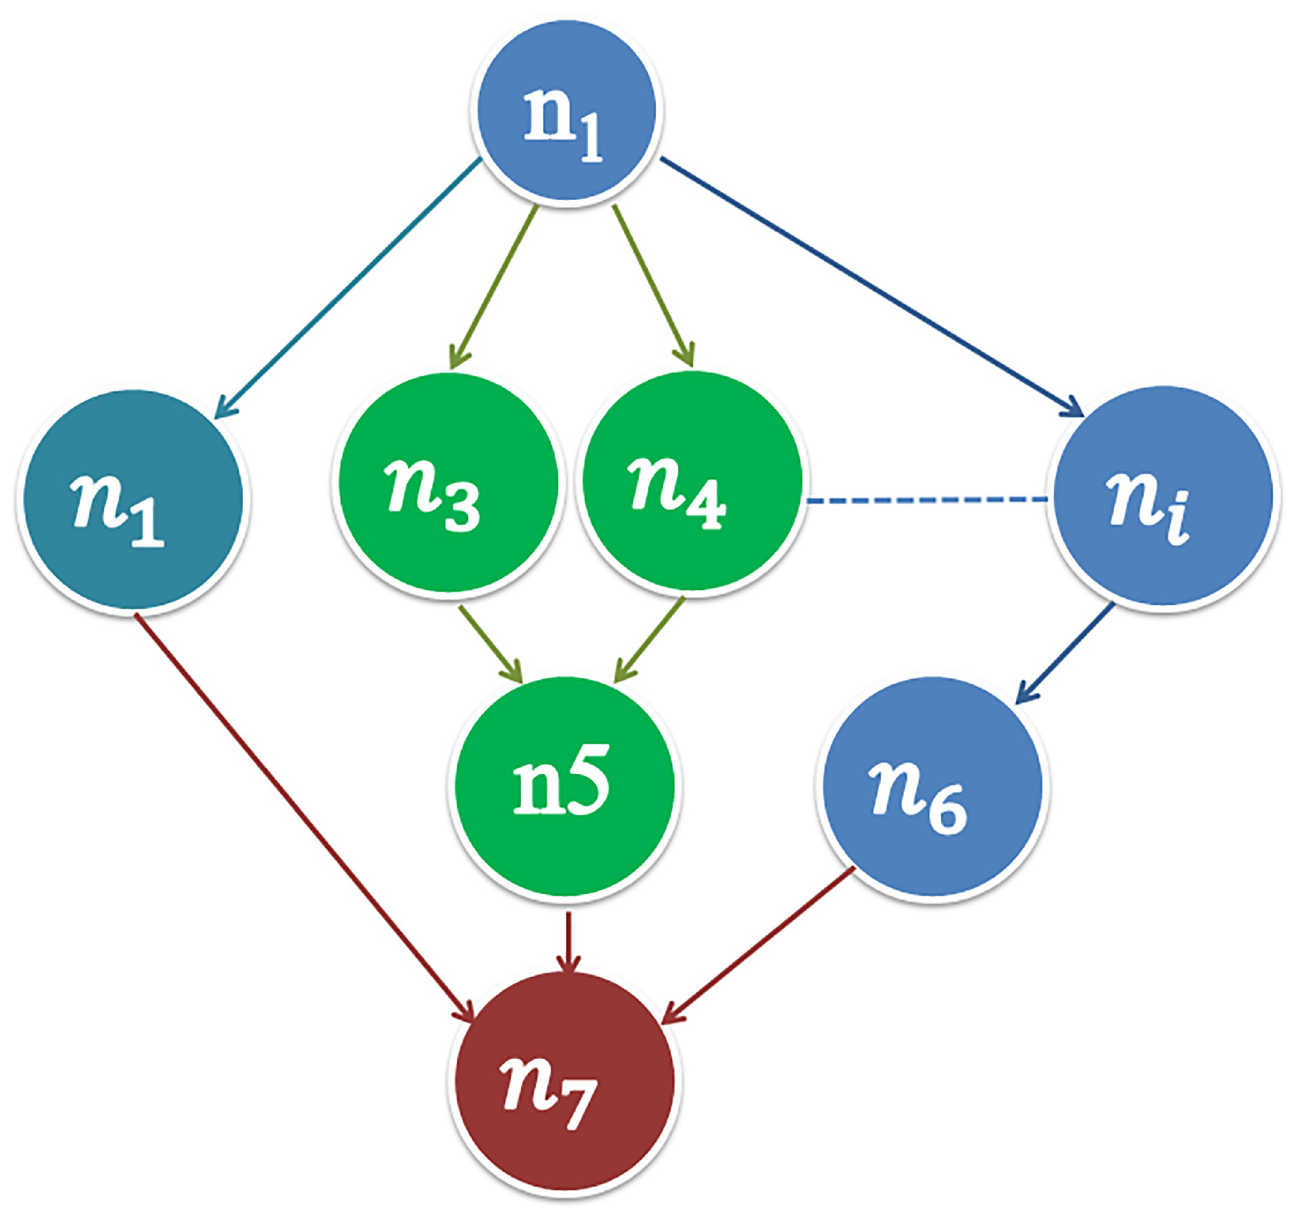
Fig 5. Example of the dependency relationship among